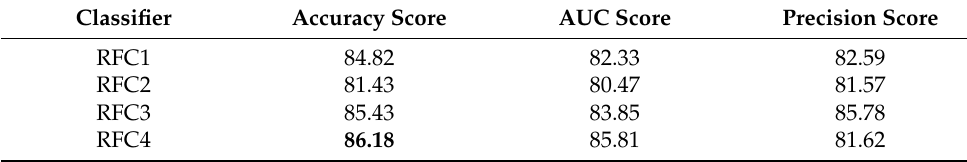
Figure 18. Cluster maps based on density of datasets. It was observed in the locational division comparison that RF still outperformed the other models. Figure 19 and Table 6 show that the RF accuracy assessment remained the best for cluster 4 with an AUC value of 0.93 and accuracy of 86.18%. Table 6. Spatial accuracy assessment of RF.